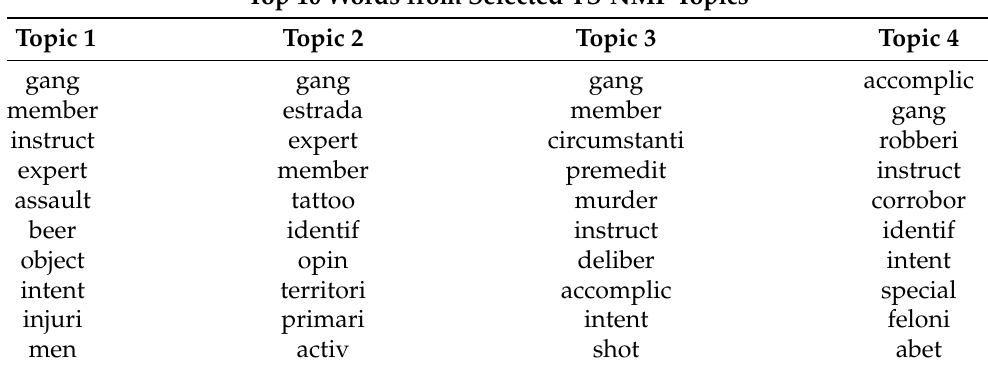
Table 3. Similar topics generated by TS-NMF. Top 10 Words from Selected TS-NMF Topics